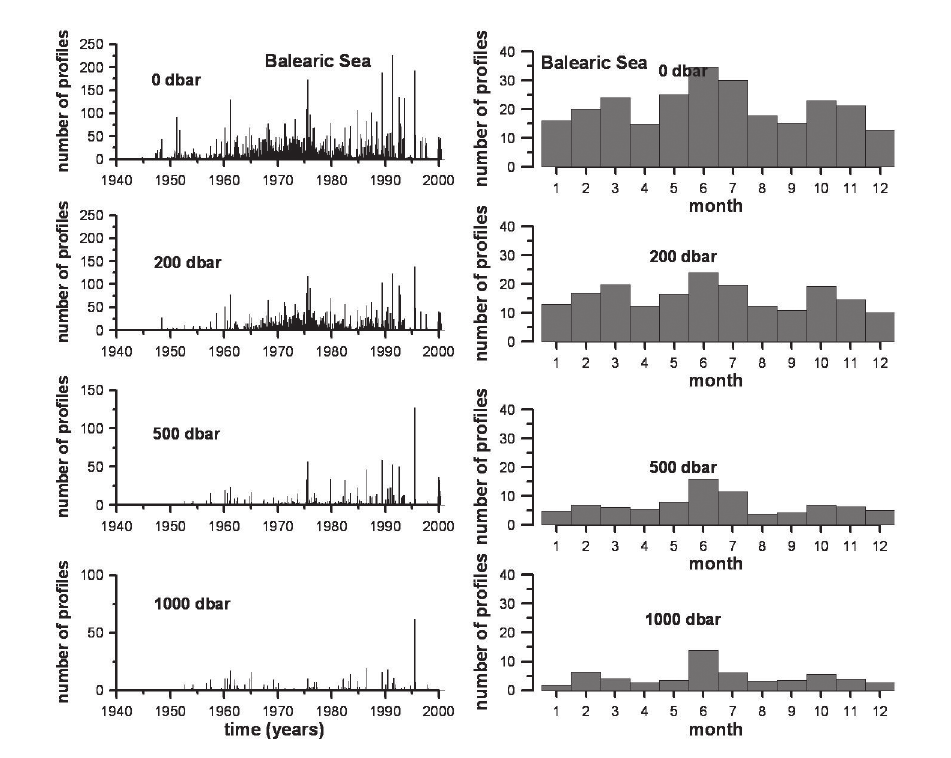
Fig . 2. – The left column shows the number of temperature data obtained for each particular month and year in the balearic sea. This is the number of data points averaged to obtain the monthly values which form the final time series analysed in this study. The right column is the mean number of data points used to obtain monthly data for each month of the